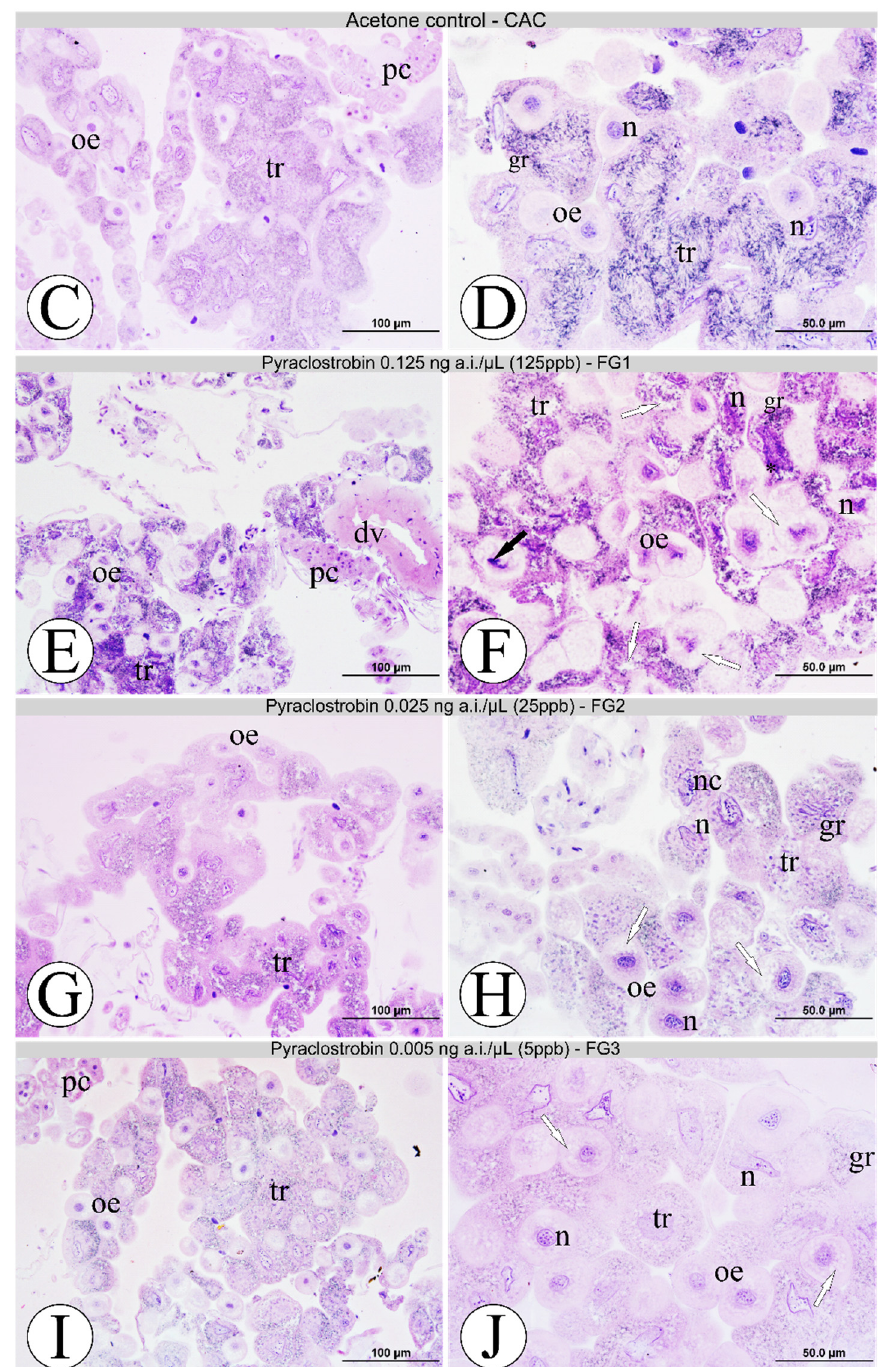
Figure 2. Fat body of foragers of Africanized honey bee after five days of oral exposure to fungicide pyraclostrobin. ( A , B ): control-CTL; ( C , D ): acetone control-CAC; ( E , F ): pyraclostrobin 0.125 ng/ µ L (125 ppb)-FG1; ( G , H ): pyraclostrobin 0.025 ng/ µ L (25 ppb)-FG2; ( I , J ): pyraclostrobin 0.005 ng/ µ L (5 ppb)-FG3. Legend : asterisk = heterochromatin on the periphery, black arrow = nuclei with condensed chromatin, dv = dorsal vessel, gr = granules, n = nuclei, nc = nucleolus, oe = oenocytes, pc = pericardial cells, tr = trophocytes, white arrow = vacuolizations. Histological sections stained with hematoxylin and eosin. N = 5 individuals per experimental